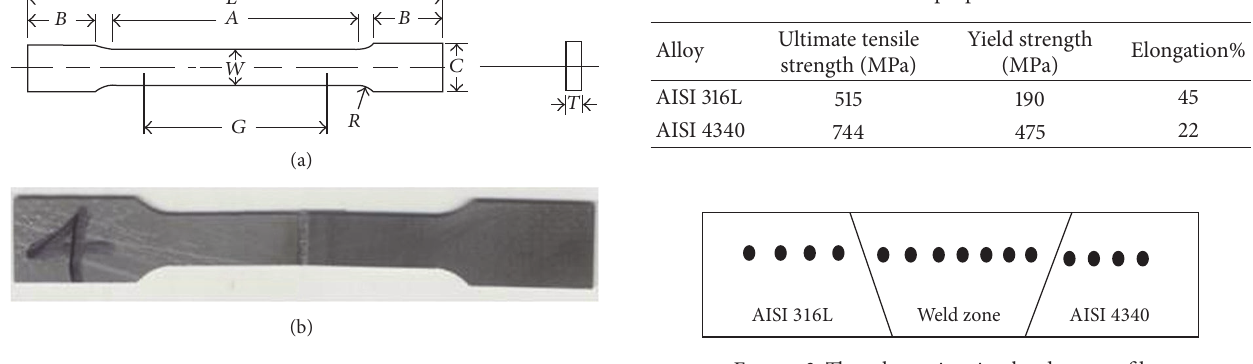
Figure 2: (a) Schematic of tensile test sample. (b) Tensile test sample